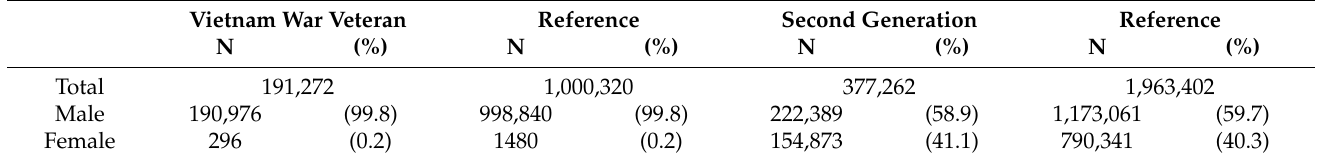
Table 1. Baseline characteristics of the Vietnam War veteran and second-generation cohort in 2002. Vietnam War